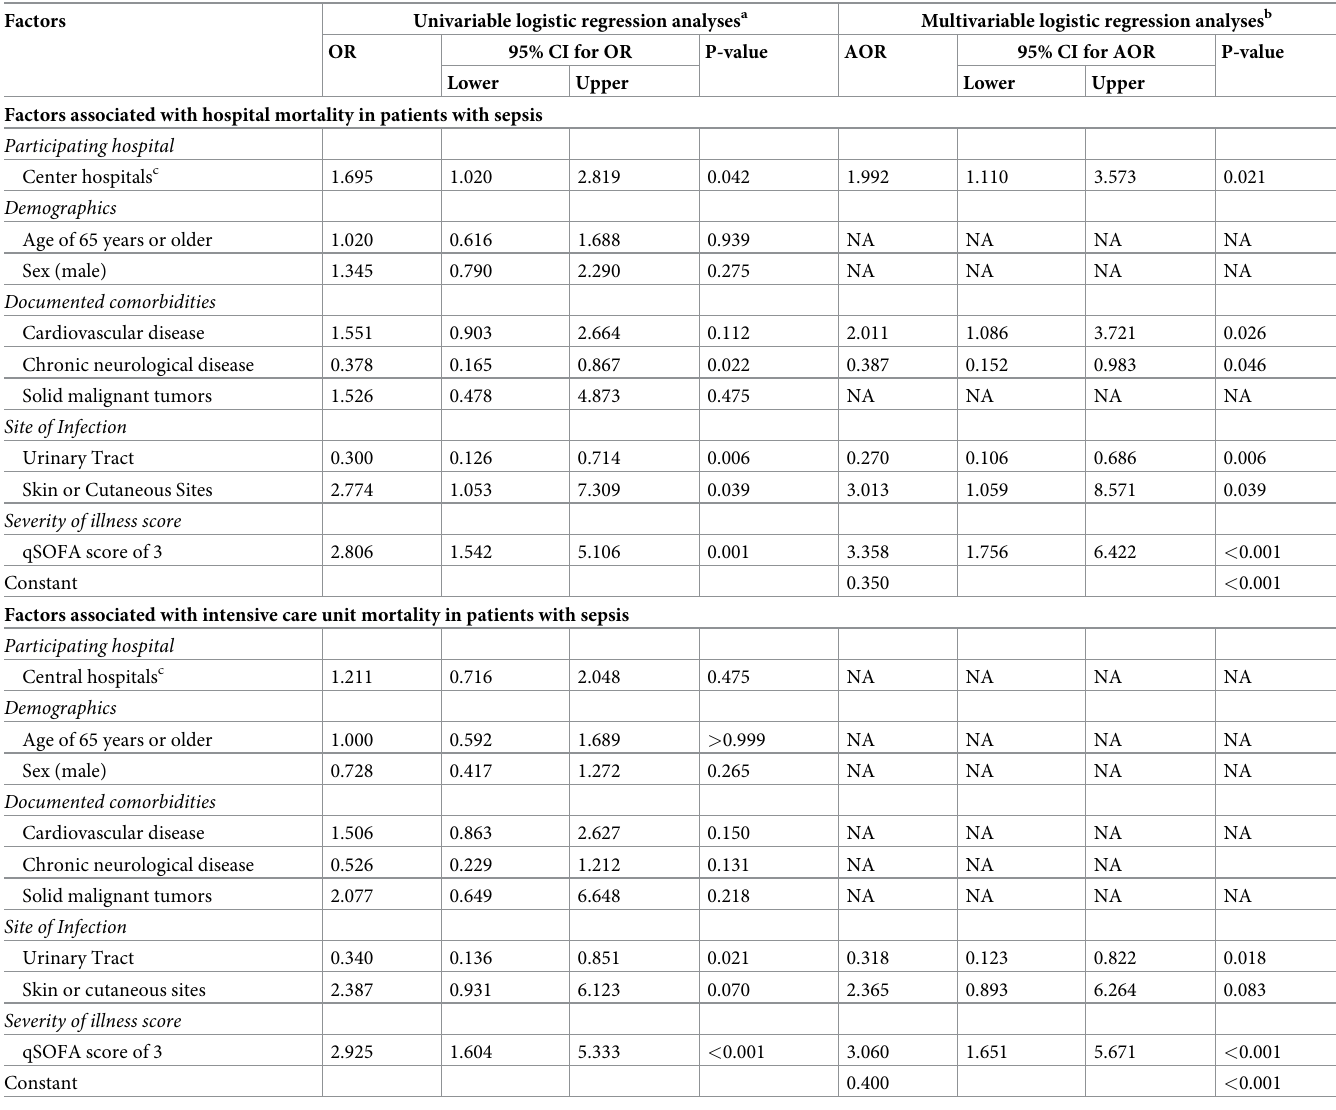
Table 3. Factors associated with mortality in patients with sepsis upon Vietnamese intensive care unit admission, 2019: Logistic regression analyses. Factors